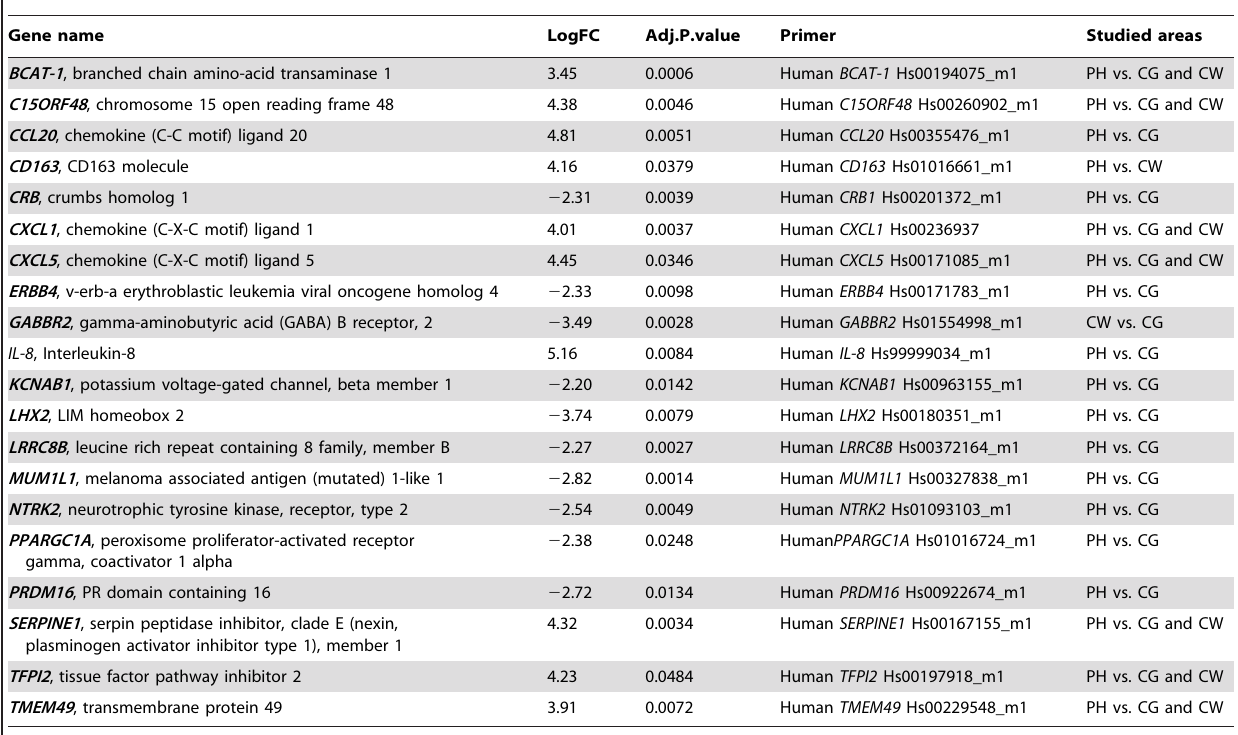
Table 3. List of selected genes and primers for quantitative